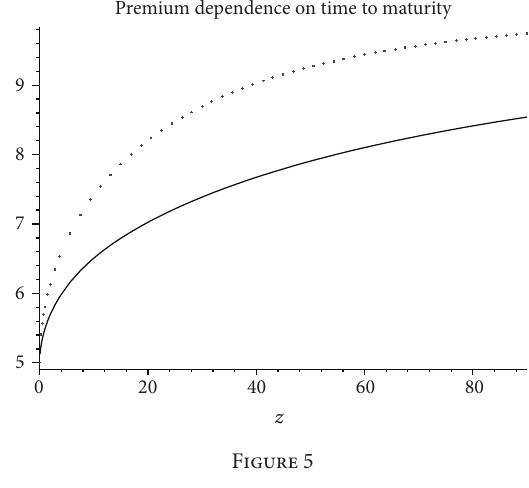
̂𝑇 = 6 , and 𝛿 = 3.5 % yr −1 .